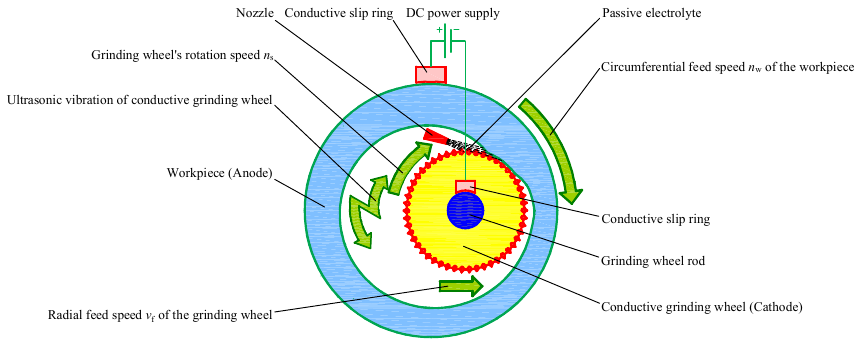
Figure 1. Schematic diagram of the ICUAECG.